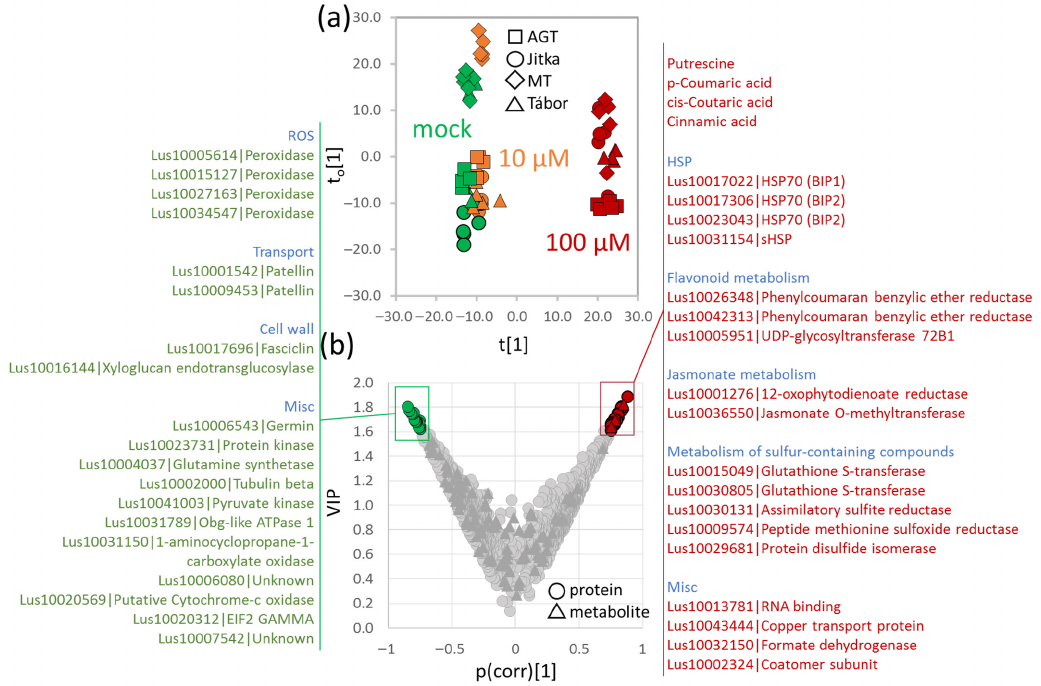
Figure 6. Identification of proteins and metabolites that show significant correlation with cadmium effects on the molecular composition of roots. Orthogonal partial least squares discriminant analysis ( a ) followed by VIP (variable importance in projection); ( b ) Identified proteins and metabolites with significant correlation (absolute threshold 0.75) are listed. For details, see Supplementary Tables S4 and S5.